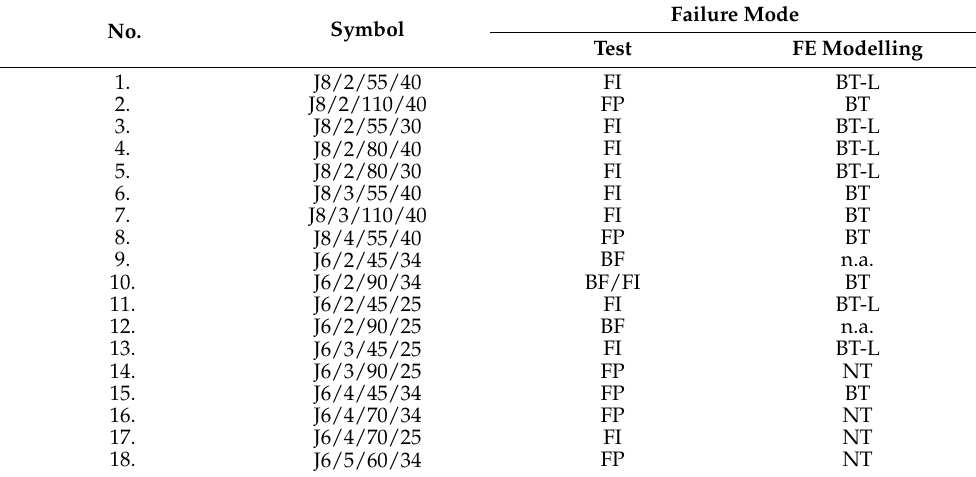
Figure 14. Path definitions: ( a ) in net cross section, ( b ) in block tearing—section along net cross section A nv , ( c ) in block tearing—section along gross cross section A gv . Table 5. Comparison of failure modes obtained from experimental tests and numerical